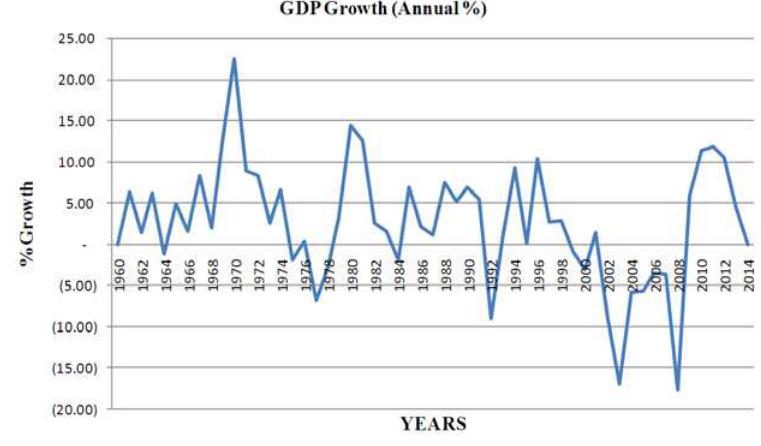
Fig. 3. GDP growth (annual %) in Zimbabwe Source: based on the World Bank (2015) World Development Indicators